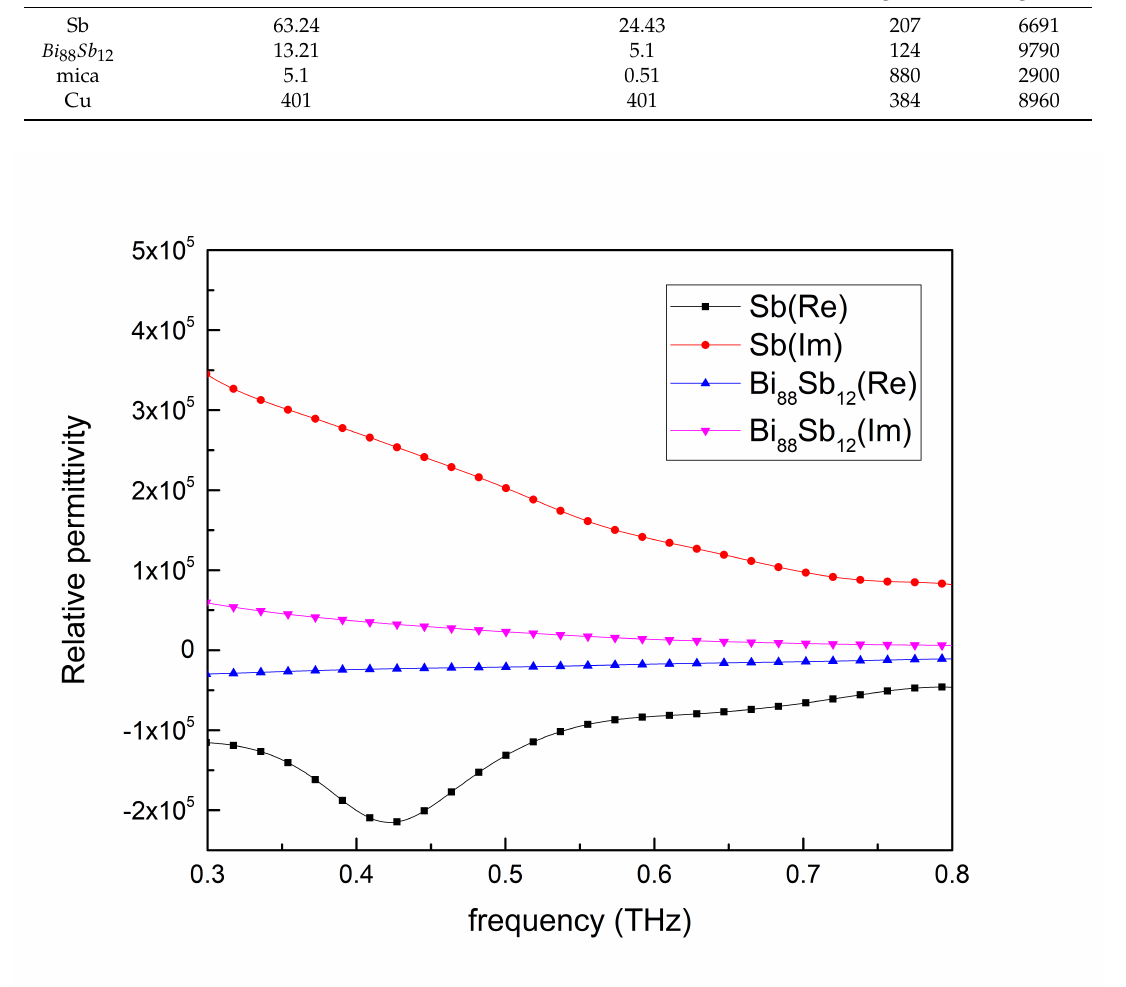
Figure 3. The real and imaginary parts of a relative permittivity of thin-film Sb and Bi 88 Sb 12 on mica substrate in the frequency range of 0.3–0.8